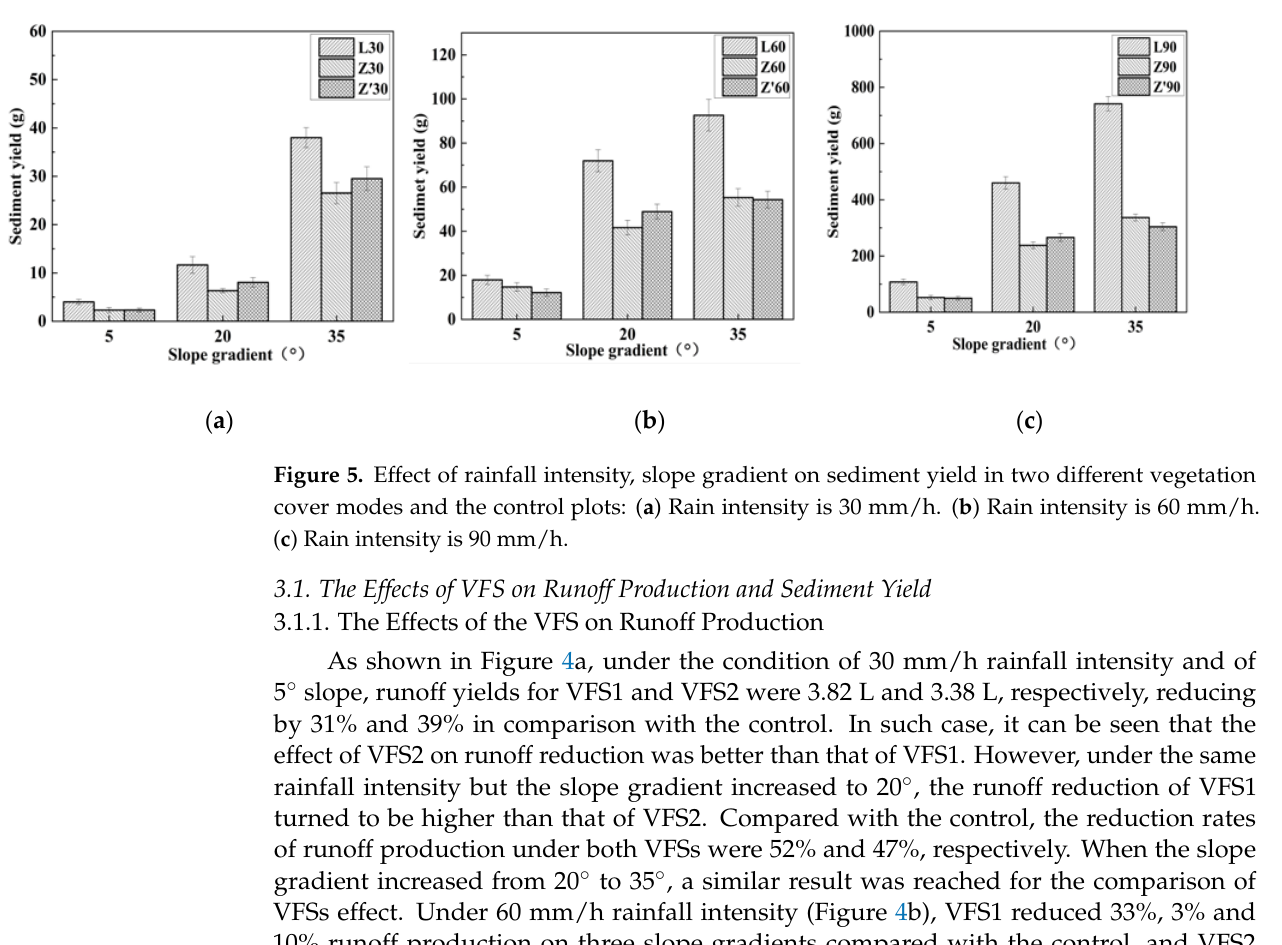
Figure 4. Effect of rainfall intensity, slope gradient on runoff in two different vegetation cover modes and the control plots: ( a ) Rain intensity is 30 mm/h; ( b ) Rain intensity is 60 mm/h; ( c ) Rain intensity is 90 mm/h.